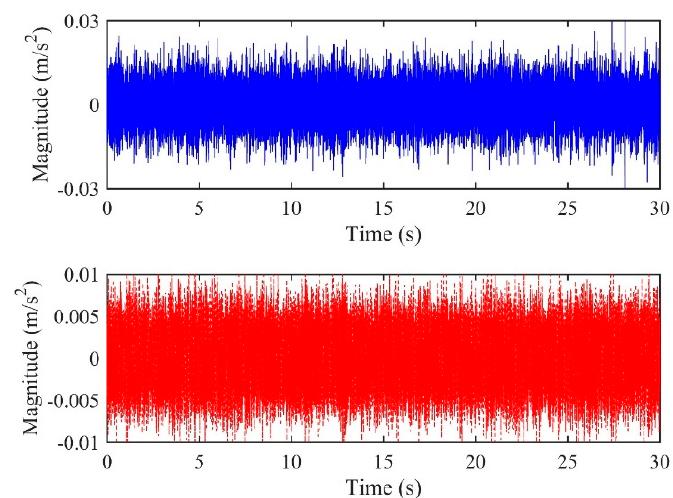
Figure 17. Leak signals measured by the accelerometer pair of ( a ) A1; ( b ) A3.